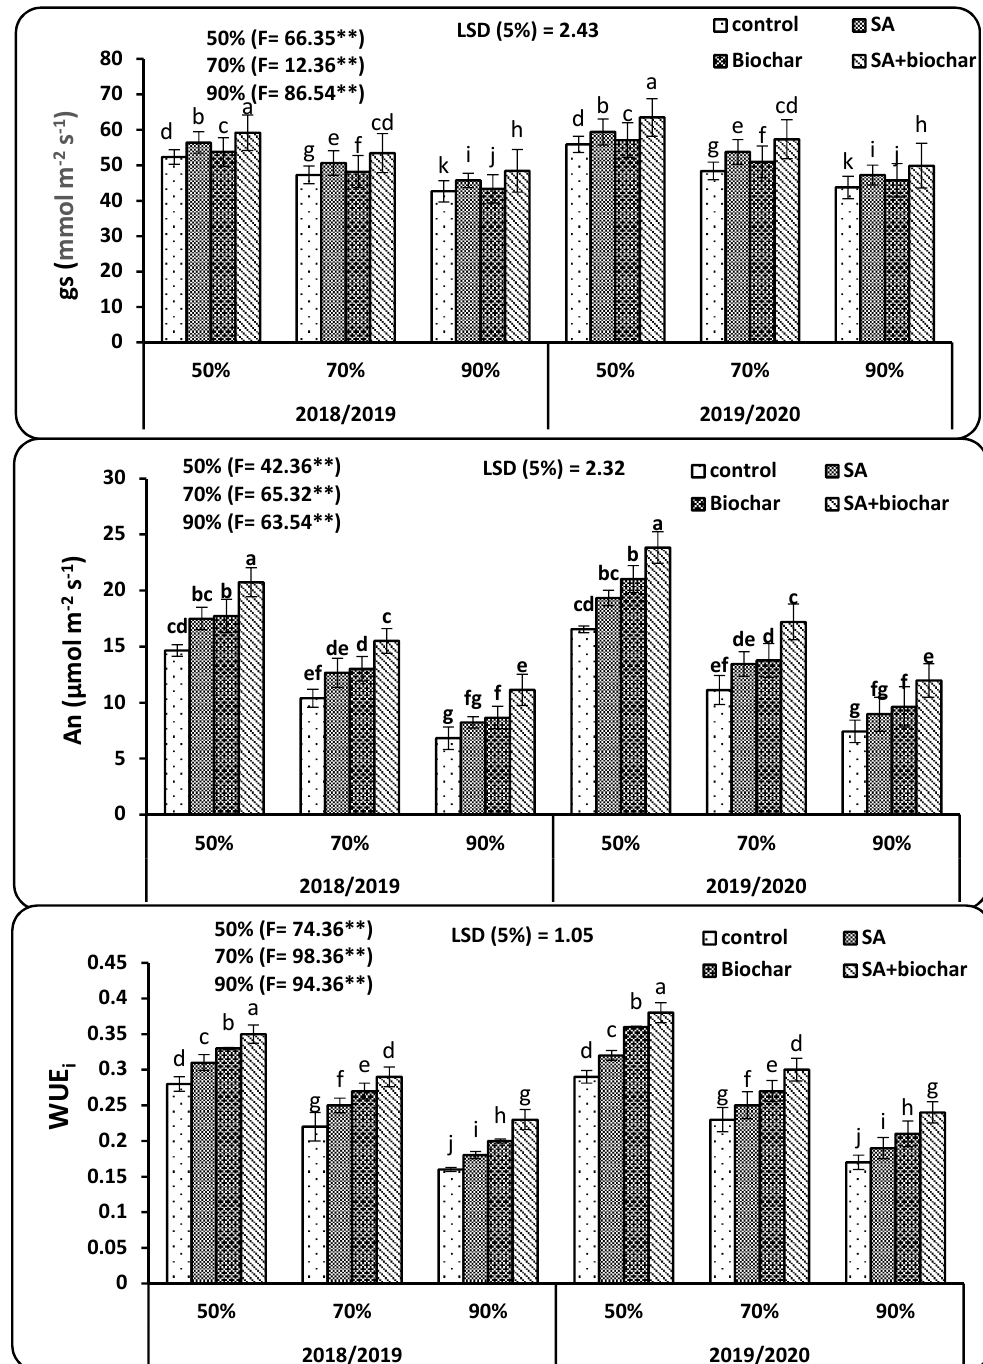
Figure 1. Stomatal conductance (g s ), leaf photosynthesis (An), and intrinsic water use e ffi ciency (WUE i ) of wheat leaves as treated by (control, salicylic acid, biochar, and SA + biochar) under di ff erent three irrigation conditions (50%, 70%, and 90% DAM) in saline sodic soil. Error bars indicate ± SE ( n = 3). SE indicates standard error. Mean values designed by the same letter in each column are not significant according to Tukey’s multiple range test. ** denote significance at P <